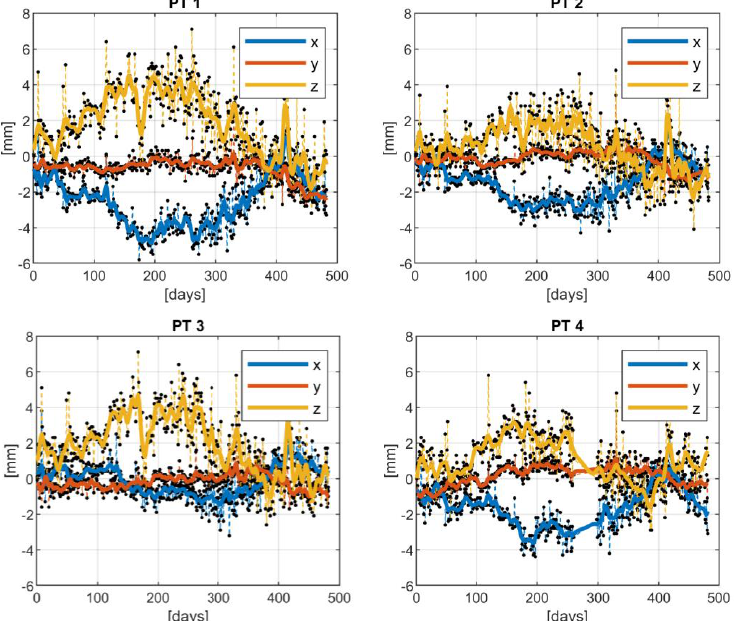
Figure 4. Estimated displacements for all the points. Solid lines represent the estimated displacements, including both the deterministic and stochastic components, while black dots joined by dashed lines represent the GNSS observations. The colors refer to the analyzed coordinate.